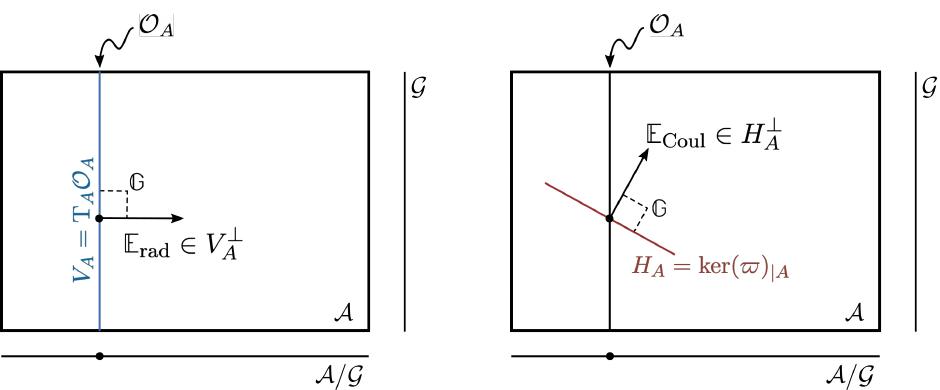
and E as vectors in the G - rad Coul and H , respectively. Notice that only with the SdW A A = V ⊥ ∈ H SdW ∈ V , one has H and therefore E and E ; that A A SdW rad Coul A A